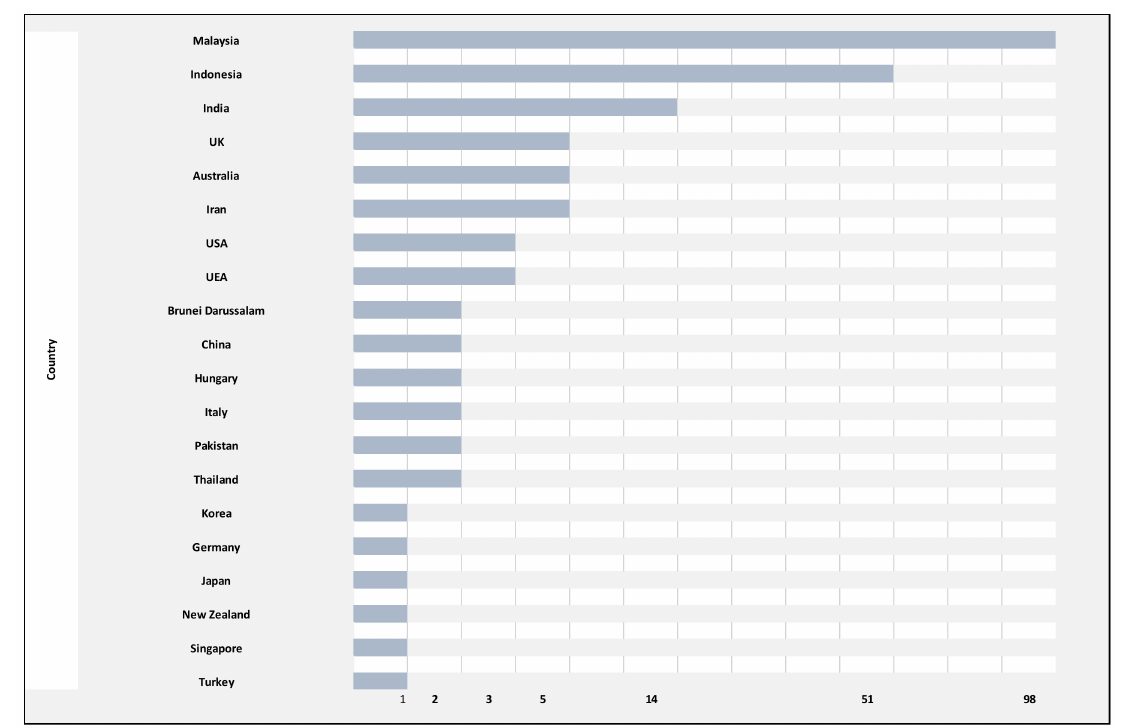
Figure 6. Ranking of scientific-article-producing countries.